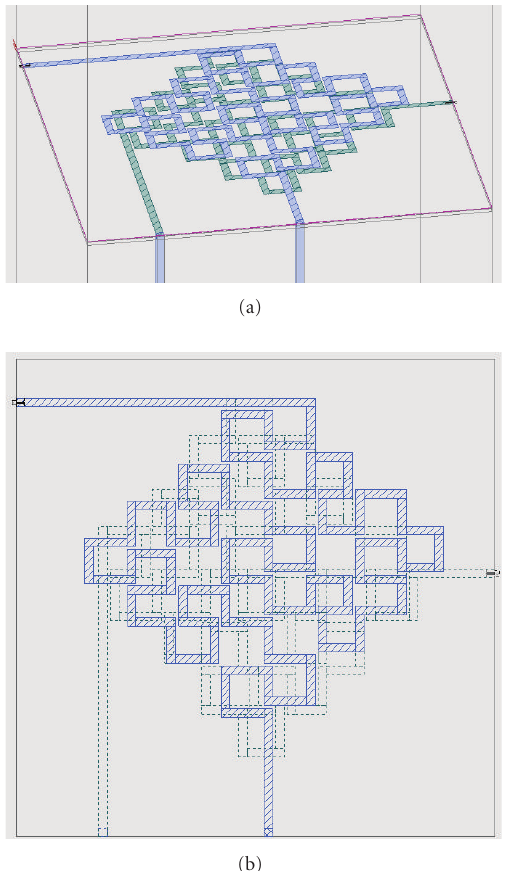
Figure 12: The Peano ( N = 2) fractal transformer: (a) 3D view, (b) the top view.